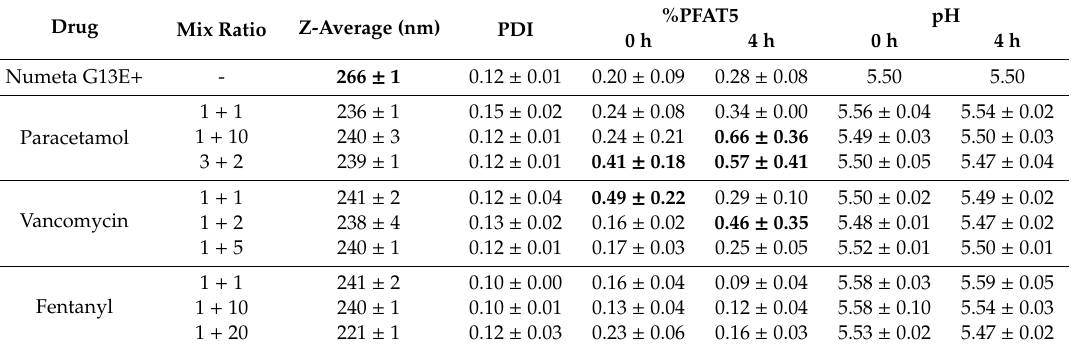
Table 7. Results from emulsion stability analysis when drug was mixed with Numeta G13E + (bold font indicate values outside the acceptance criteria) (average ± SD; n =